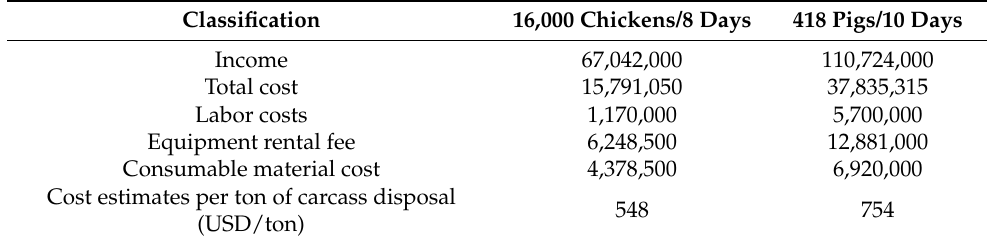
Table 2. Economic analysis for treating buried chickens and pigs using thermo-chemically treatment system. Unit: